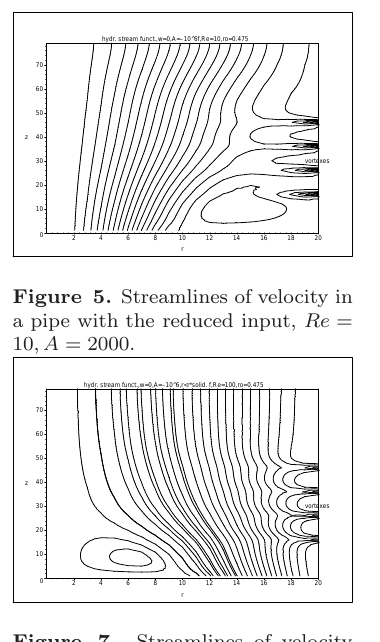
Figure 8. Streamlines of velocity in a pipe with the ring input, Re = 100 ,A = − 2000 .